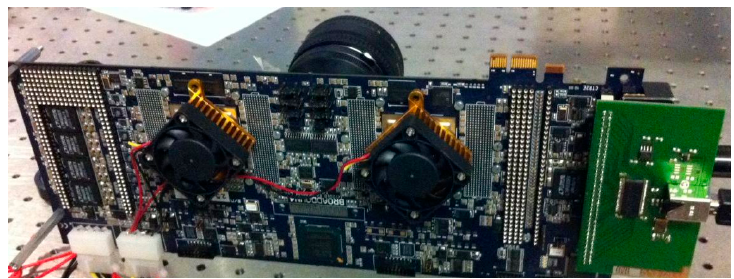
Figure 15. Physical appearance of the camera based on SwissSPAD; a daughterboard hosting the chip is electrically connected to a motherboard hosting two Xilinx-IV that process the raw frames generated by the chip and format them to send them through a USB2 link.